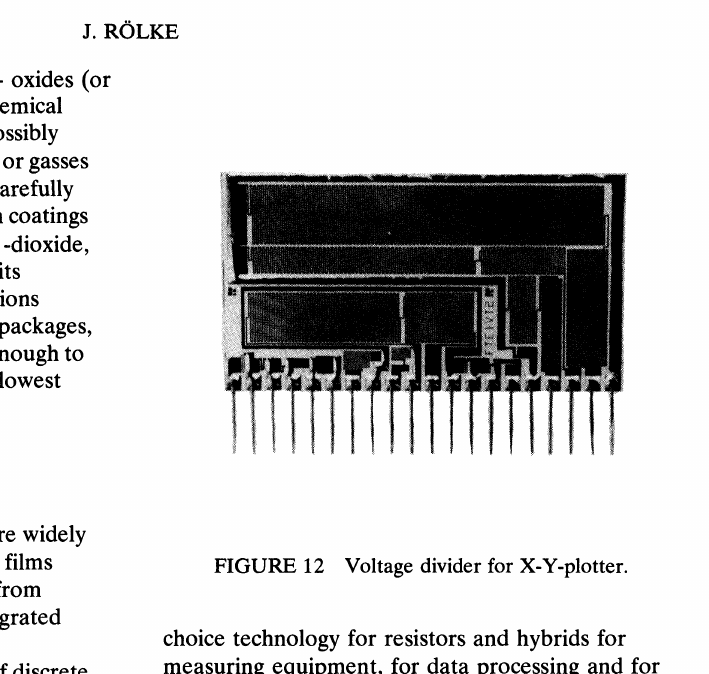
FIGURE 12 Voltage divider for X-Y-plotter.